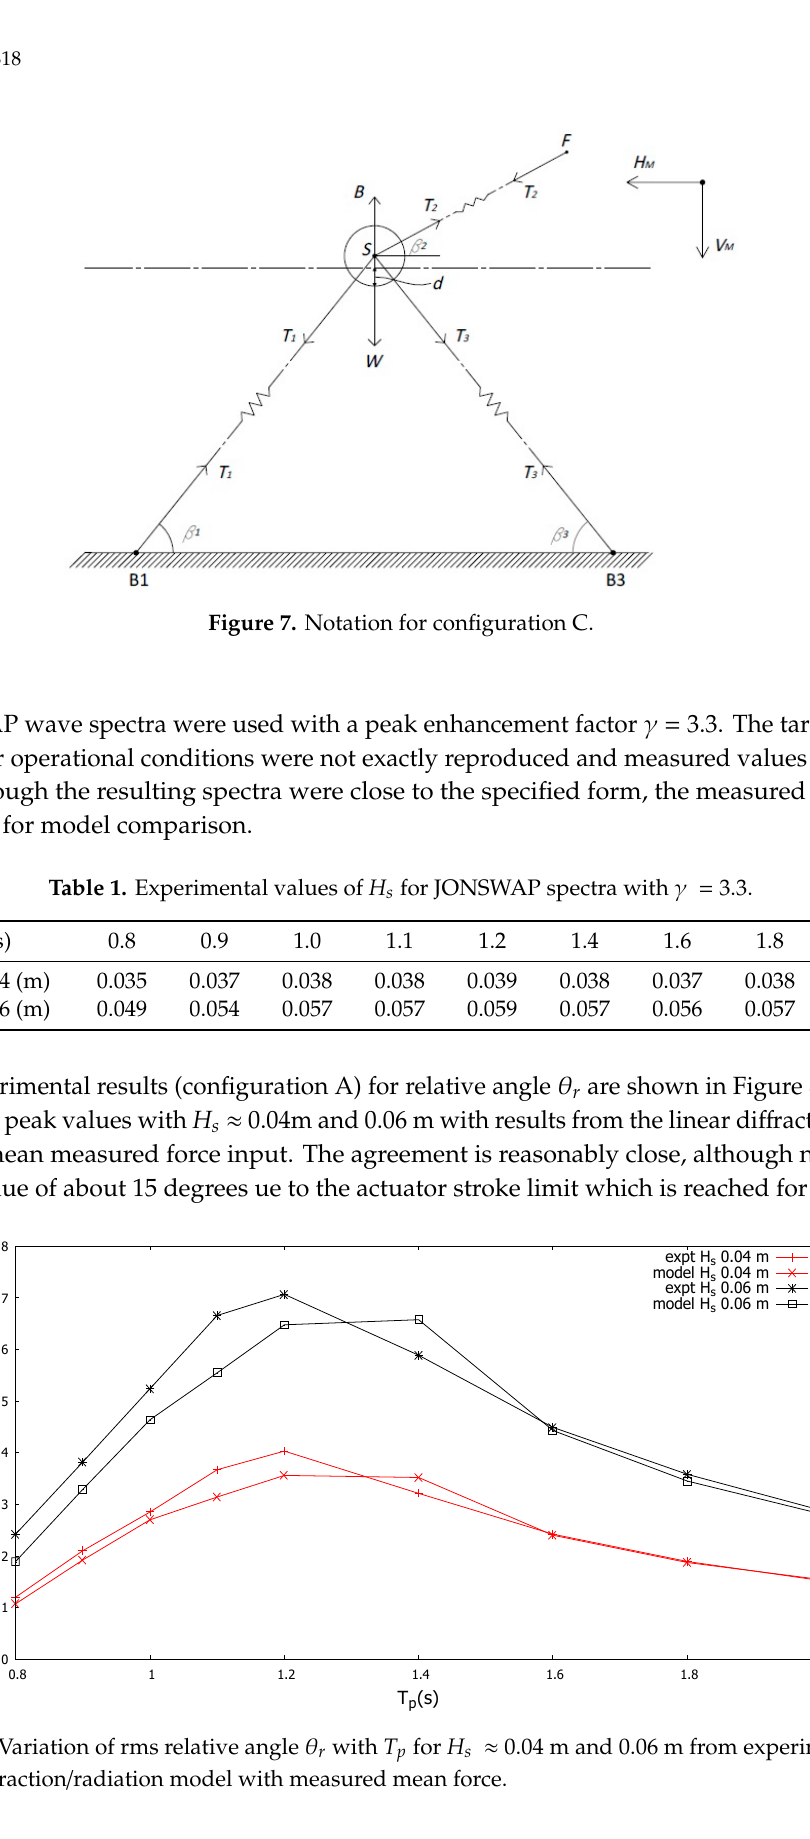
Figure 8. Variation of rms relative angle θ r with T p for H s ≈ 0.04 m and 0.06 m from experiment and linear diffraction/radiation model with measured mean force.